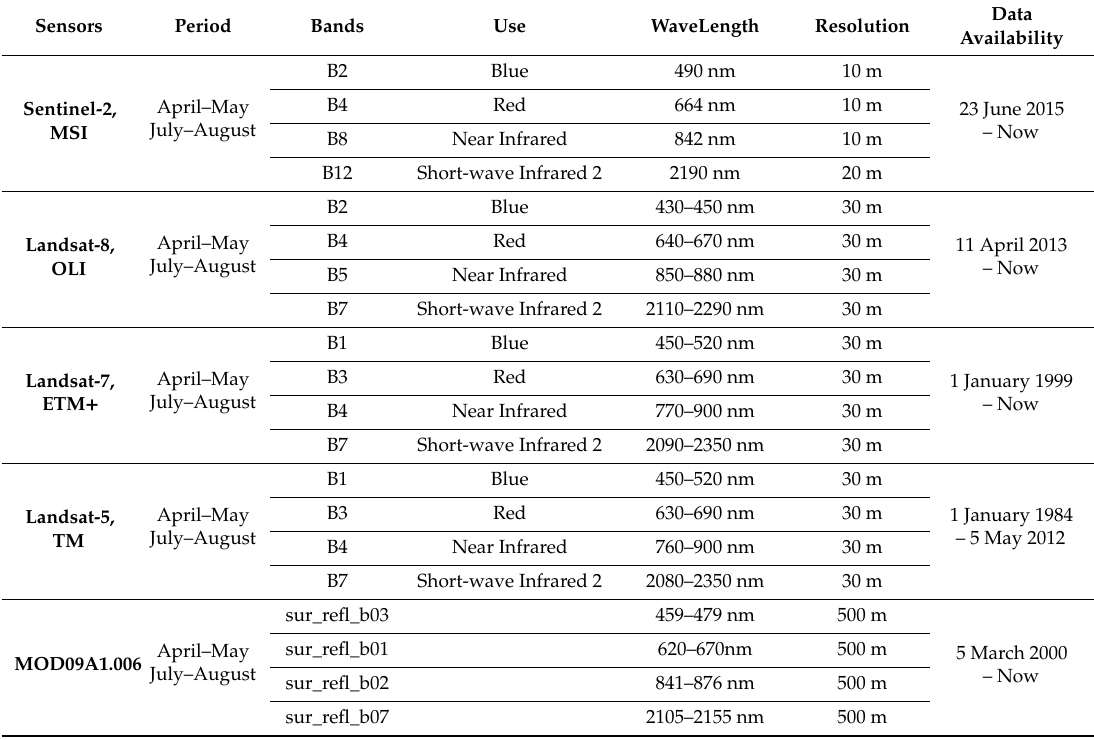
Table 2. Characteristics of Sentinel-2 Multispectral Instrument (MSI), Landsat-8 (Operational Land Imager) OLI, Landsat-7 (Enhanced Thematic Mapper Plus) ETM + , Landsat-5 (Thematic Mapper) TM, and MOD09A1.006 bands used in this